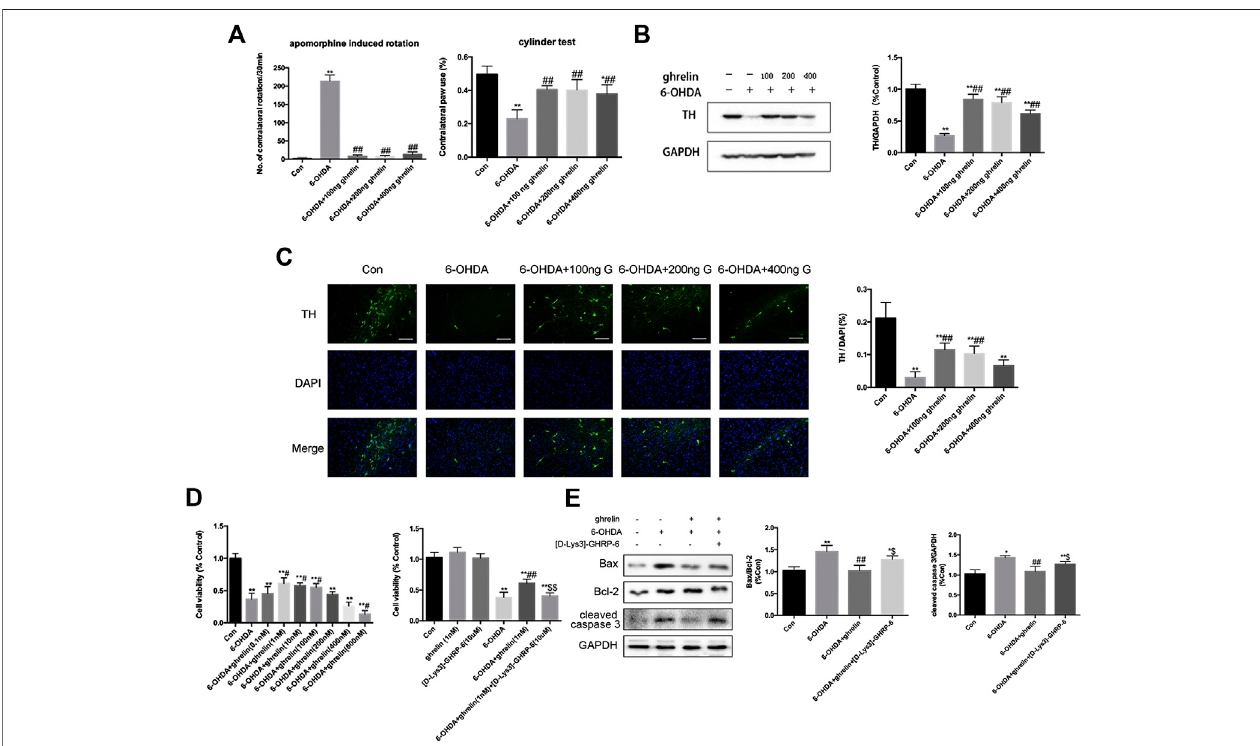
FIGURE1| Ghrelinisprotectiveagainst6-OHDA-inducedneurotoxicity. (A) Theeffectofghrelinonapomorphine-inducedrotationsandcylindertest5 weeksafter 6-OHDA intoxication. The net number of apomorphine-induced rotations/30 min and the percentage of contralateral paw use were recorded. (B) Representative westernblotandquanti fi cationofTHexpressionintherightsubstantianigra5weeksafter6-OHDAintoxication;GAPDHwasappliedastheloadingcontrolandforband density normalization. (C) Representative immuno fl uorescence and quanti fi cation ofTHn the right substantia nigra 5weeksafter 6-OHDA intoxication, scale bar (cid:2) 50 μ m. (D) Cell viability assessment of SH-SY5Y cells treated with 6-OHDA with different concentrations of ghrelin or 10 μ M [D-Lys3]-GHRP-6 for 24 h. (E) Representativewesternblotandquanti fi cationofapoptosis-relatedmarkersexpressionintherightsubstantianigra1 dayafter6-OHDAintoxication.Dataarepresented as mean ± SD; * p < 0.05 vs. the control group, ** p < 0.01 vs. the control group, # p < 0.05 vs. the 6-OHDA group, ## p < 0.01 vs. the 6-OHDA group, $$ p < 0.01 vs. the 6-OHDA + ghrelin group, n (cid:2)